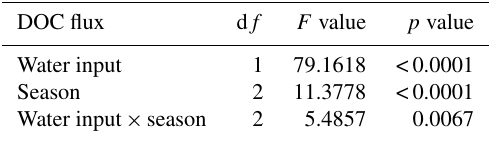
Table 3. Two-way ANOVA results examining the effect of water input, season, and their interaction on DOC fluxes. Data plotted in Fig.